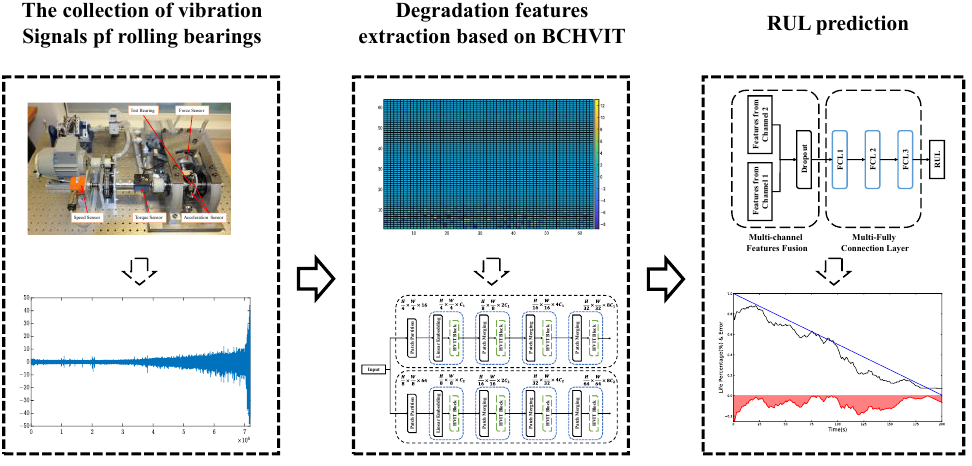
Figure 4. The network structure of RUL prediction based on BCHViT.